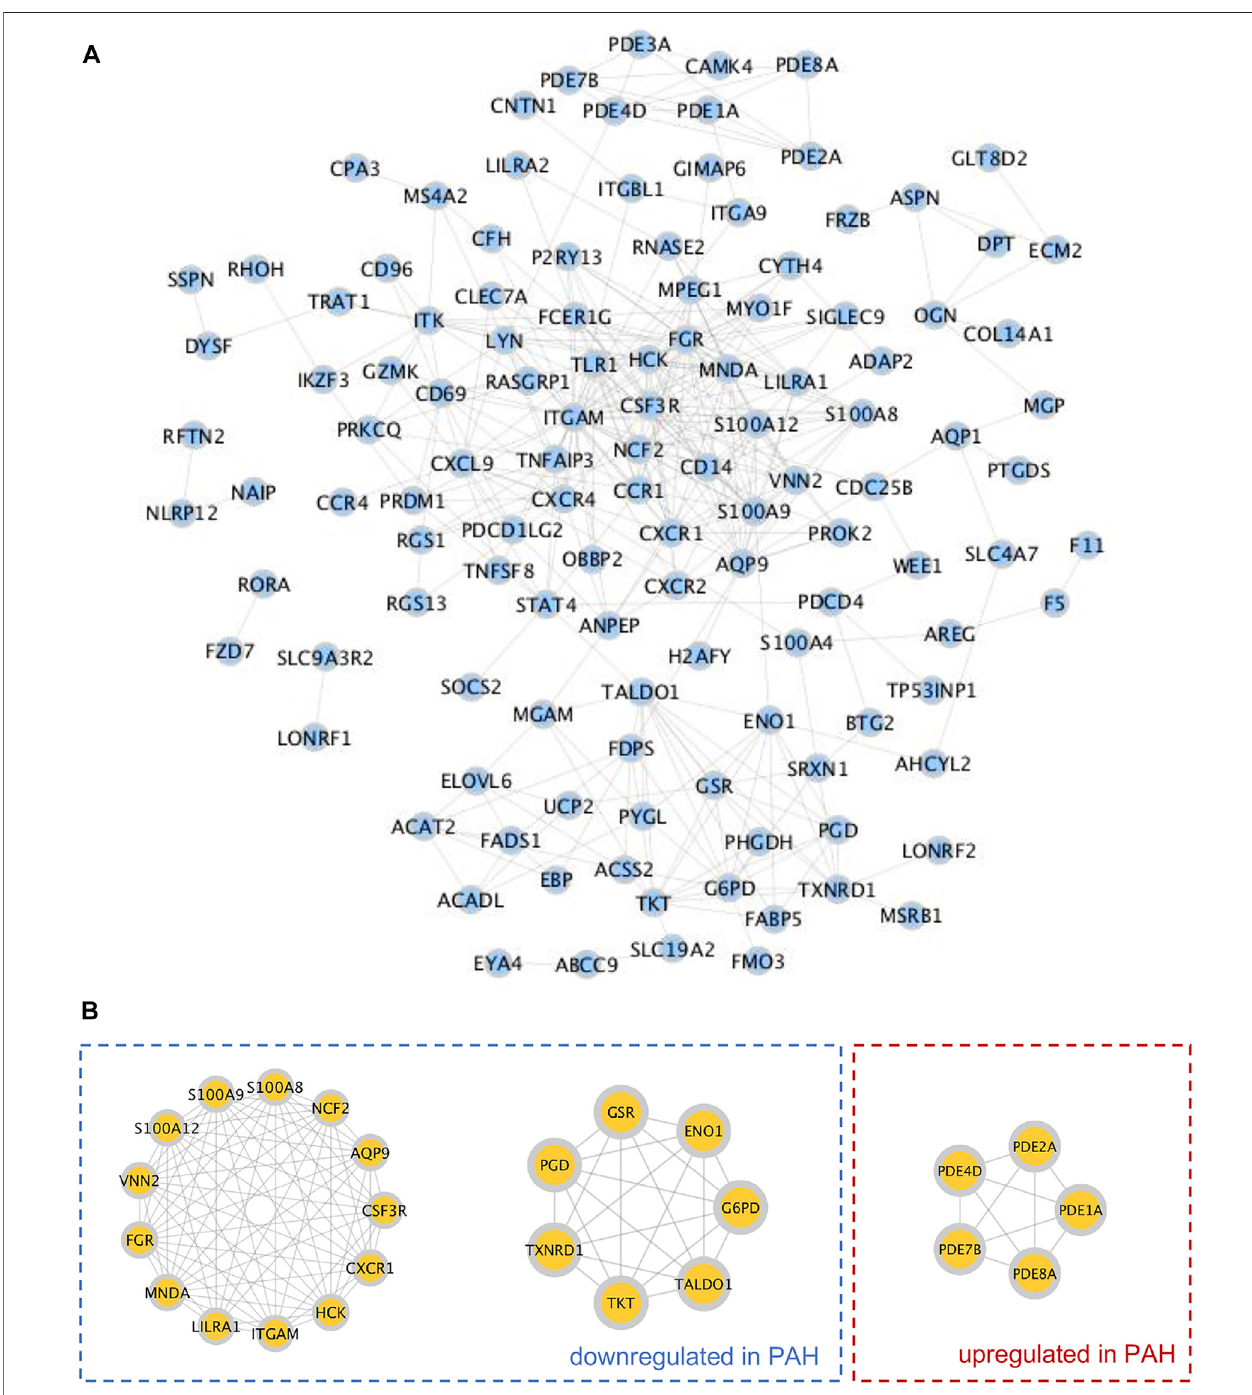
FIGURE 3 | Construction of the protein – protein interaction (PPI) network and identi fi cation of hub TRGs. (A) PPI network was constructed by the STRING database, and each blue fi lled circle represents a TRG. (B) Hub genes were screened out by the MCODE plugin in Cytoscape and categorized into three clusters. Hub TRGs in the left ( fi rst) and middle (second) clusters were downregulated in lungs of PAH patients compared to those of controls of the GSE117261 dataset. The hub TRGs in the right (third) cluster were upregulated in lungs of PAH patients compared to those of controls in the same dataset.